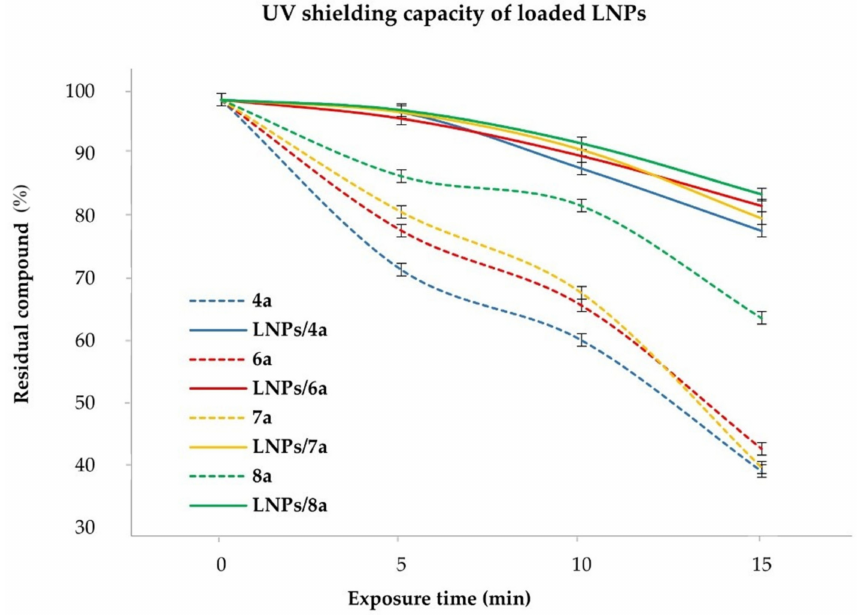
Figure 3. UV shielding capacity of LNPs. The photo-protective effect is expressed as the amount of residual 4a , 6a , 7a , and 8a recovered after UV treatment of LNPs/ 4a , LNPs/ 6a , LNPs/ 7a , and LNPs/ 8a